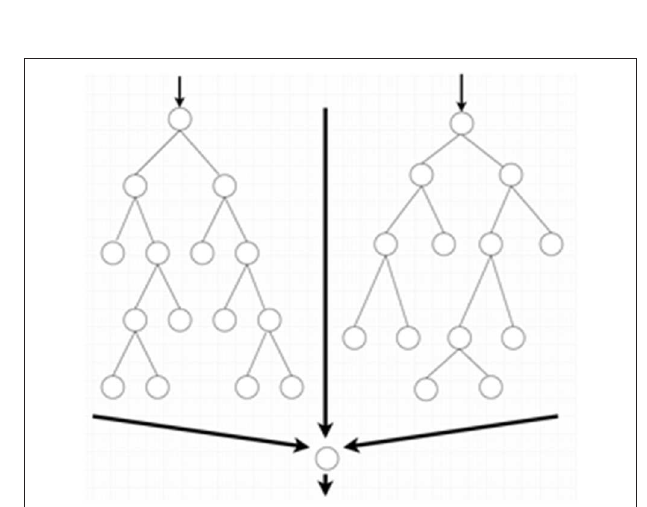
FIGURE 3 | Random forest algorithms by developing multiple decision trees and merging them get more accurate predictions.